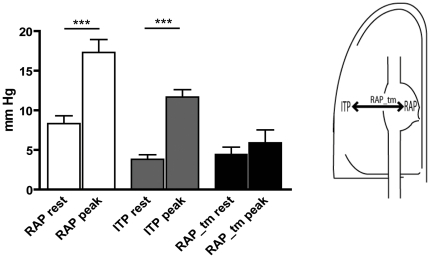
The right atrial (RAP) and intrathoracic pressure (ITP) at rest and peak exercise.Note the rise in RAP and ITP as the transmural pressure of the right atrium (RAP_tm) remains constant. RAP_tm is calculated as pressure inside the right atrium (RAP) minus the pressure outside the right atrium, which is the ITP. *** = P<0.0001.